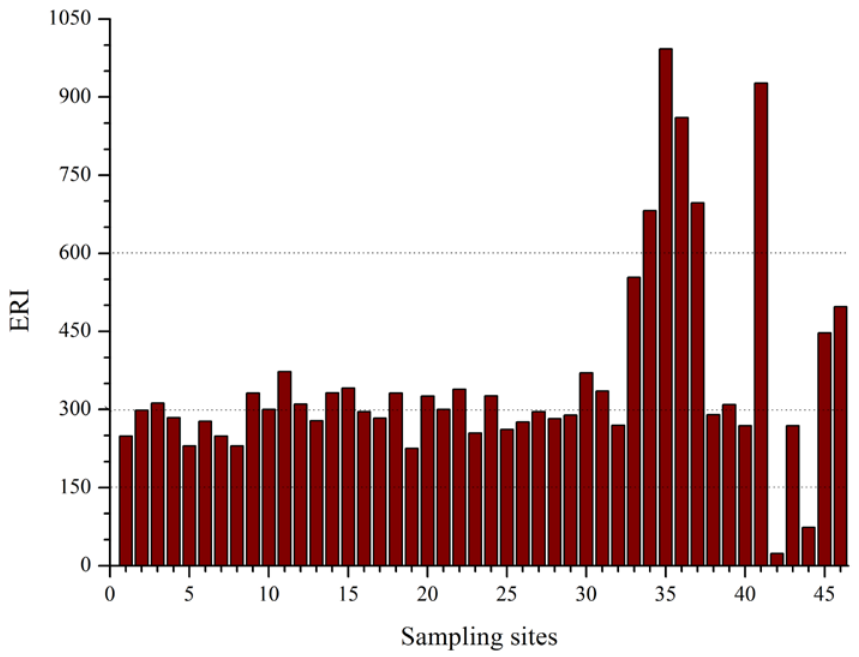
Figure 4. Summary of potential ecological risk index (ERI) values of Awash River Basin.